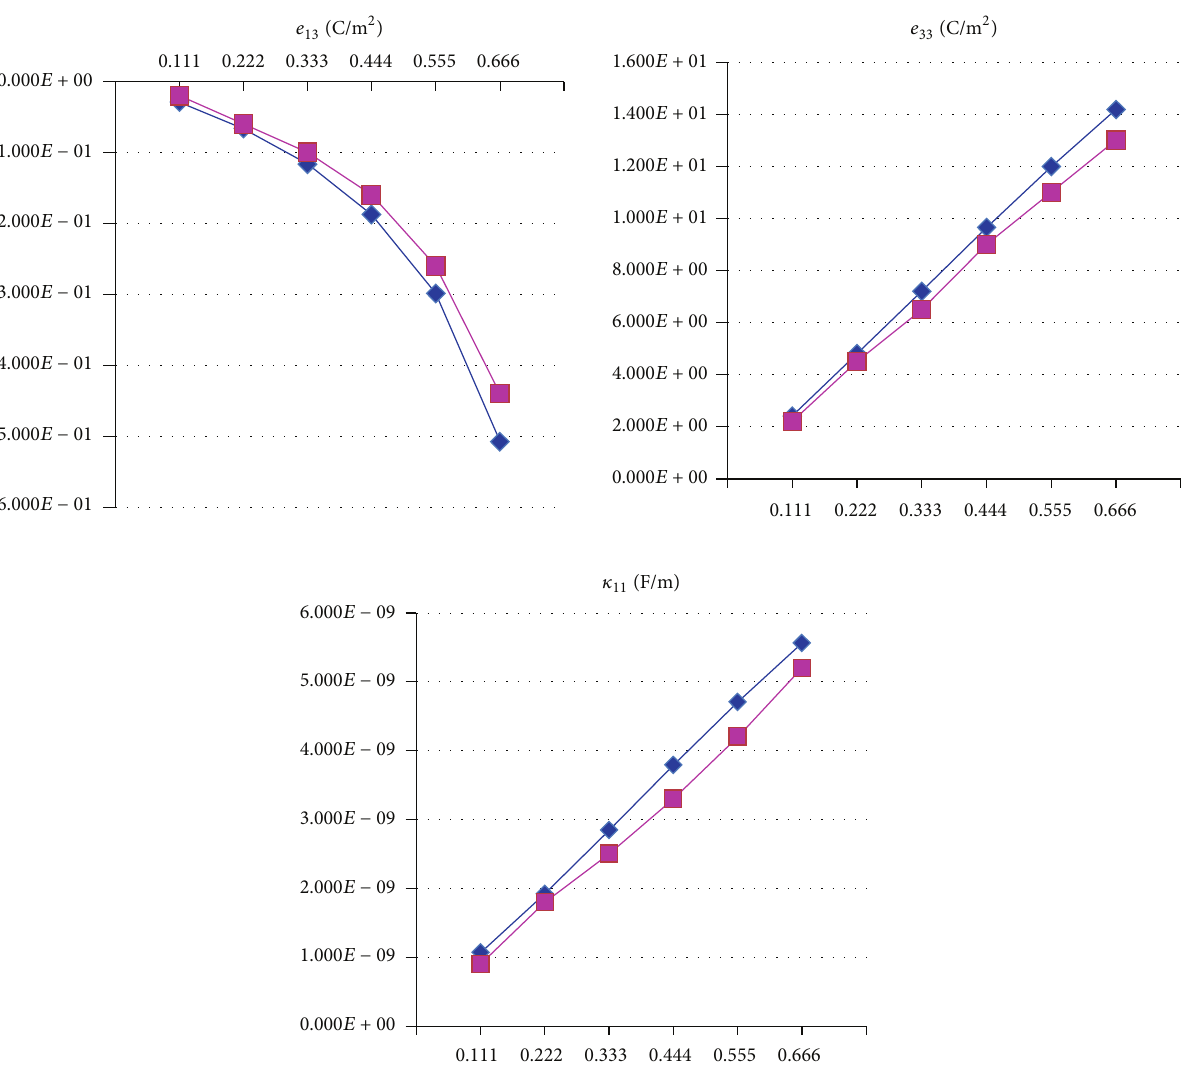
Figure 5: Numerical results of effective